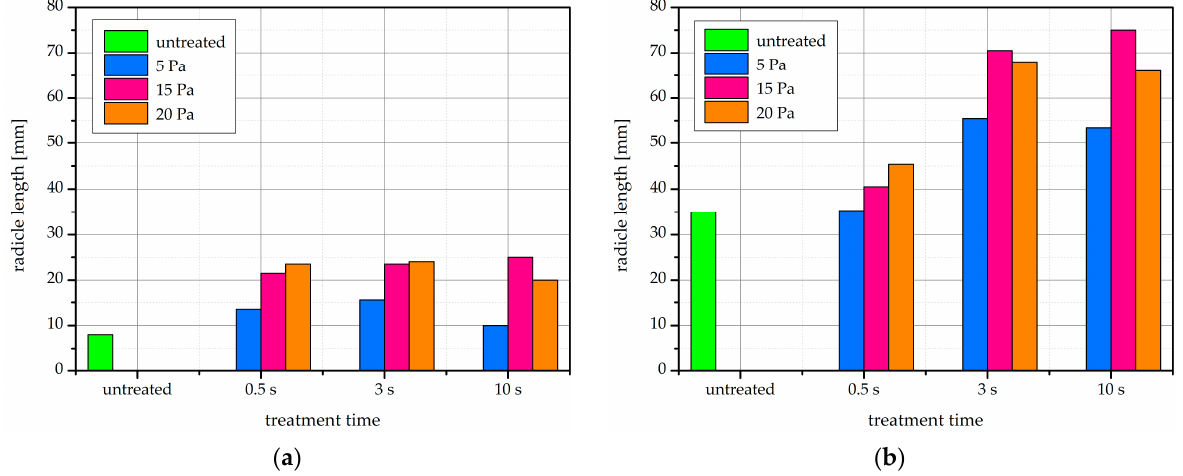
Int. J. Mol. Sci. 2021 , 22 , x FOR PEER REVIEW 12 of 20